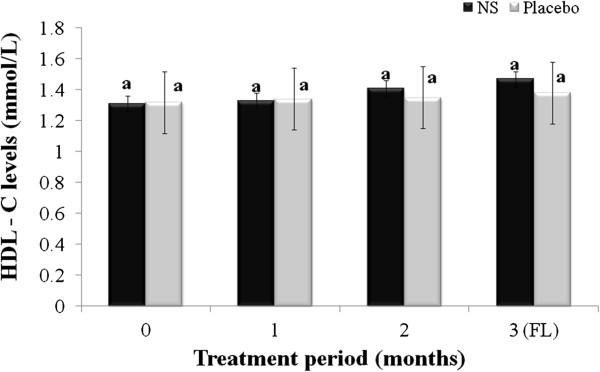
Changes in serum high density lipoprotein (HDL); menopausal women randomly assigned to Nigella sativa (N.S) or placebo groups were treated for 2 months and blood samples taken at baseline, and 1 and 2 months after the start of the intervention, and one month after cessation of intervention (FL), and used to evaluate serum HDL. Results are expressed as mean ± SD. *significant between N. S vs. placebo group at p < 0.05. Different letters on bars representing different intervals for the same group indicate significant difference between the intervals for the same treatment (p < 0.05).